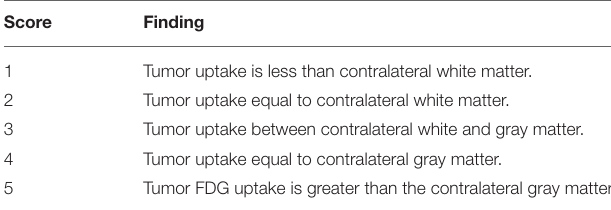
TABLE 1 | Schifter FDG PET primary brain tumor visual analysis